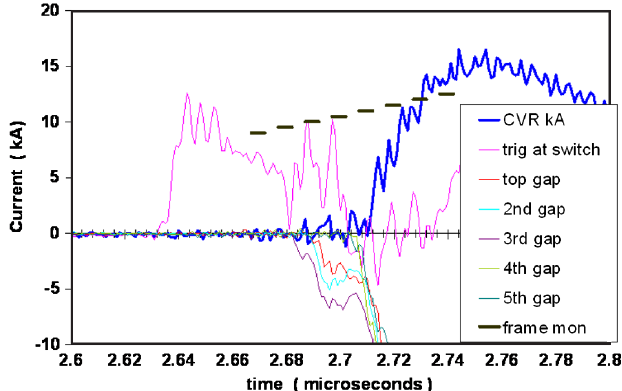
FIG. 22. (Color) Graph of trigger voltage, switch current, and negative light signals on shot with the Russian switch discharg- ing two each 20 nF capacitors. The times of the 5-ns-wide framing camera images in Fig. 21 are also listed. The trigger voltages and light signals are in arbitrary units.